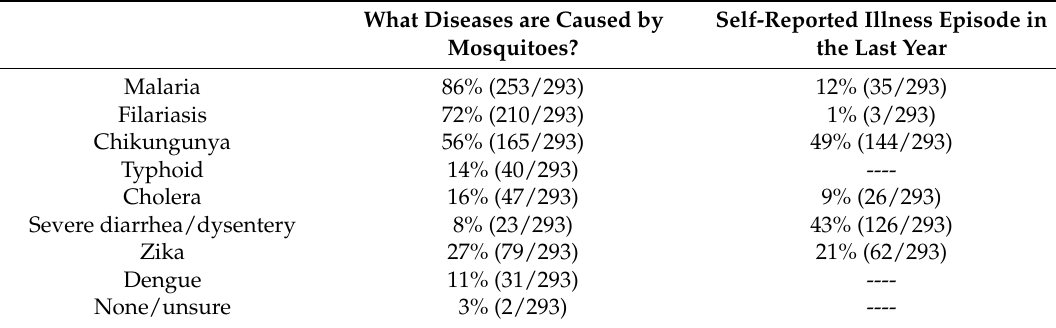
Table 2. Knowledge and Experience of Disease. What Diseases are Caused